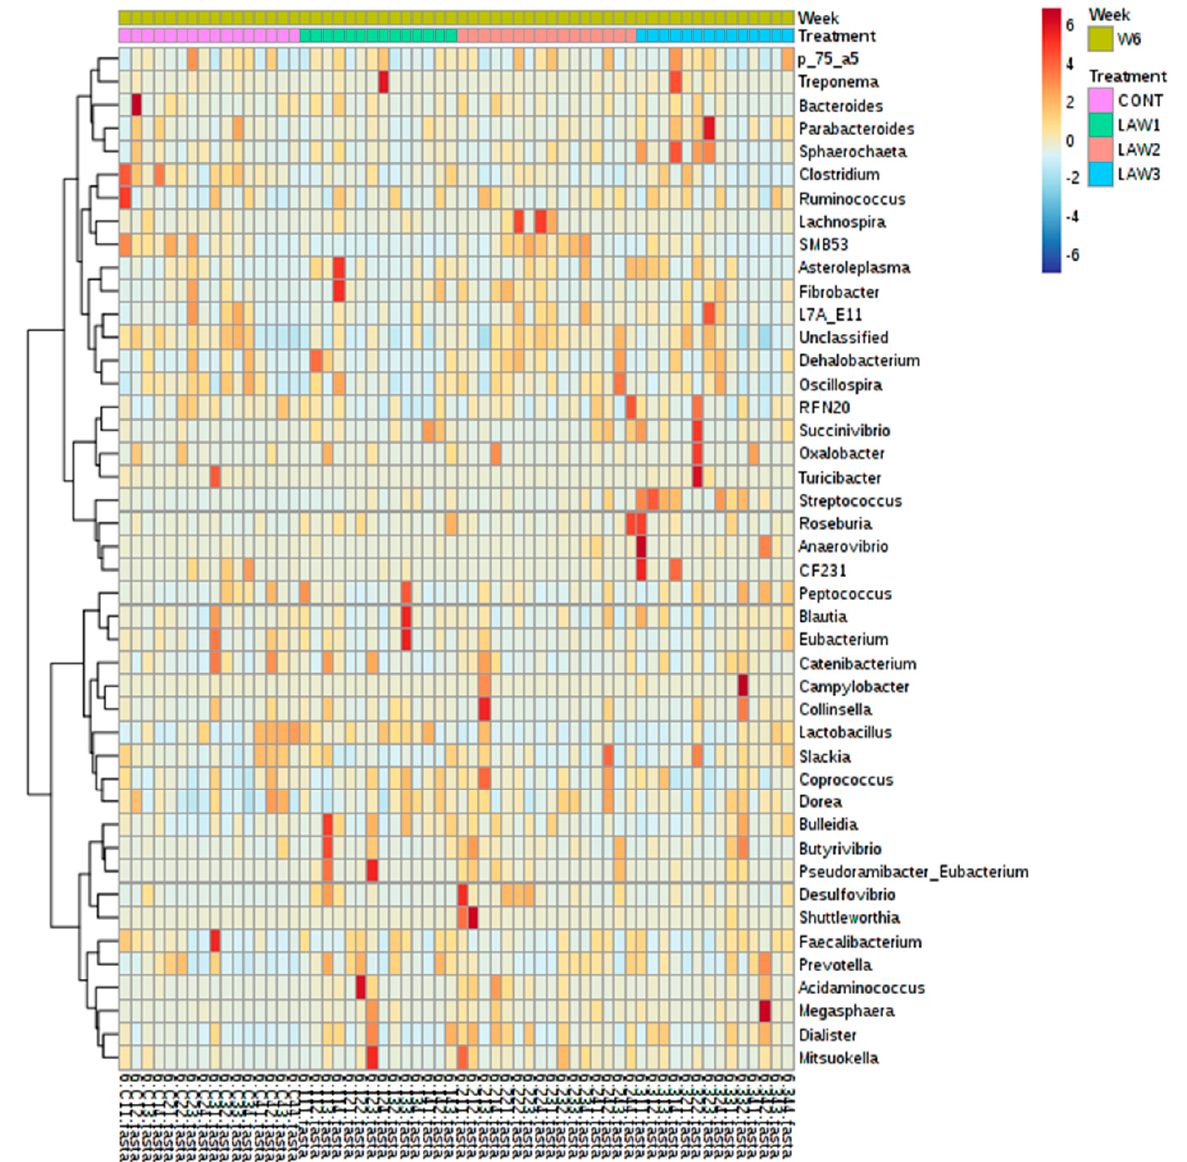
Figure 8. Hierarchical clustering heatmap of bacterial genera among the treatment groups (CONT, LAW1, LAW2, and LAW3) at week 6 based on Euclidean distance measure and Ward clustering algorithm.